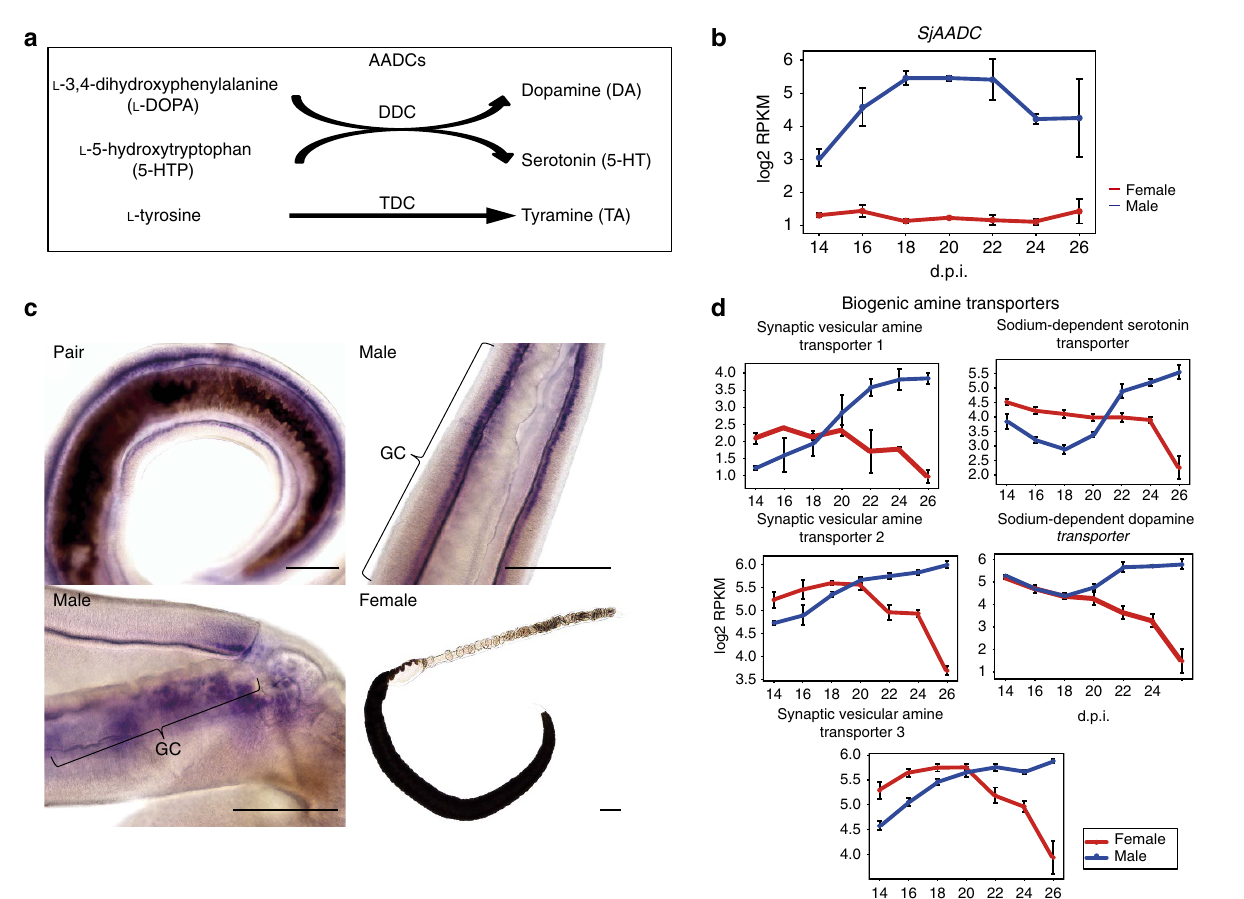
Figure 4 | Expression of the gene encoding aromatic- L -amino-acid decarboxylase in S. japonicum ( Sj AADC) and amine transporters. ( a ) AADC is involved in biosynthesis of biogenic amines. DDC, dopa decarboxylase; TDC, tyrosine decarboxylase. ( b ) The expression pattern of SjAADC in both sexes at 14–26d.p.i. Red, female; blue, male (mean ± s.e.m., n ¼ 3). ( c ) Whole-mount in situ hybridization of the SjAADC gene. Purple-blue colour indicates positive signals. n 4 3 parasites. GC, gynecophoral canal. Scale bars, 500 m m. ( d ) The expression pattern of biogenic amine transporters. Synaptic vesicular amine transporter 1,2,3: 4 comp5540_c1_seq1 (CAX69443); 4 comp5301_c0_seq1 (CAX82642); 4 comp3717_c0_seq1 (AAX26794). Sodium-dependent serotonin transporter ( 4 comp4792_c0_seq2); sodium-dependent dopamine transporter ( 4 comp6056_c0_seq1) (mean ± s.e.m., n ¼ 3). NATURE COMMUNICATIONS|8:14693|DOI: